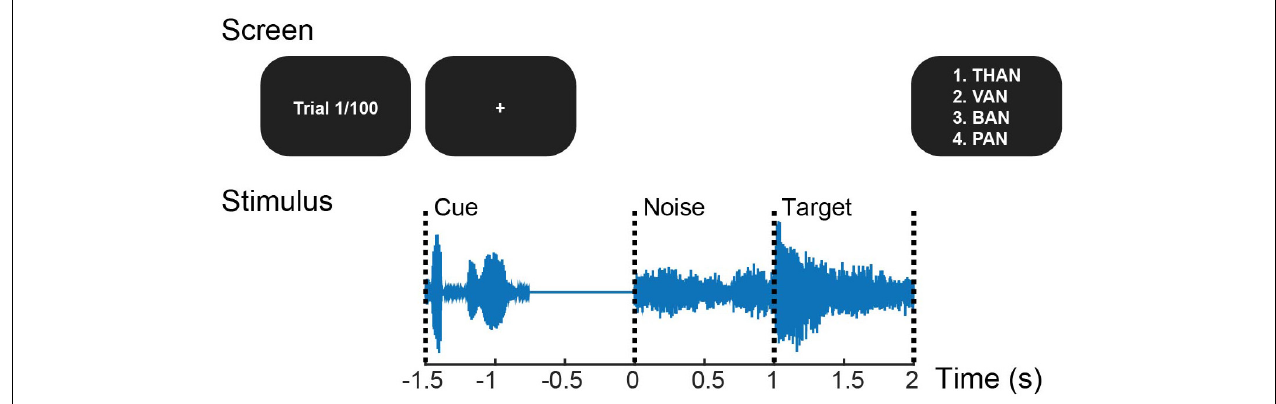
FIGURE 2 | Trial structure of the pre- and post-training speech-in-noise task. At each trial that starts with the cue phrase “check the word,” a target word is presented a second after the noise onset. At the end of the trial, four choices are given, and the listener presses the button to answer.